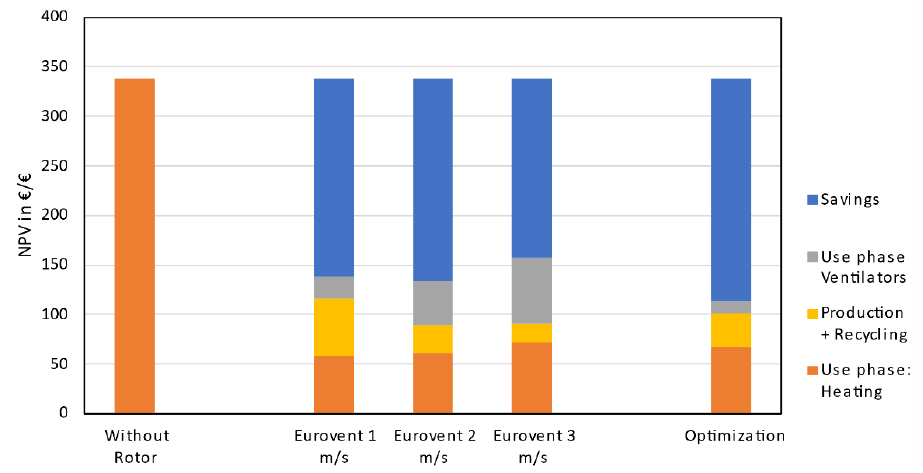
Figure A1. 65 €/t CO 2 Eq. scenario with optimized RHX and Eurovent RHX under different operating ambient air empty tube velocities at 100,000 m 3 /h.